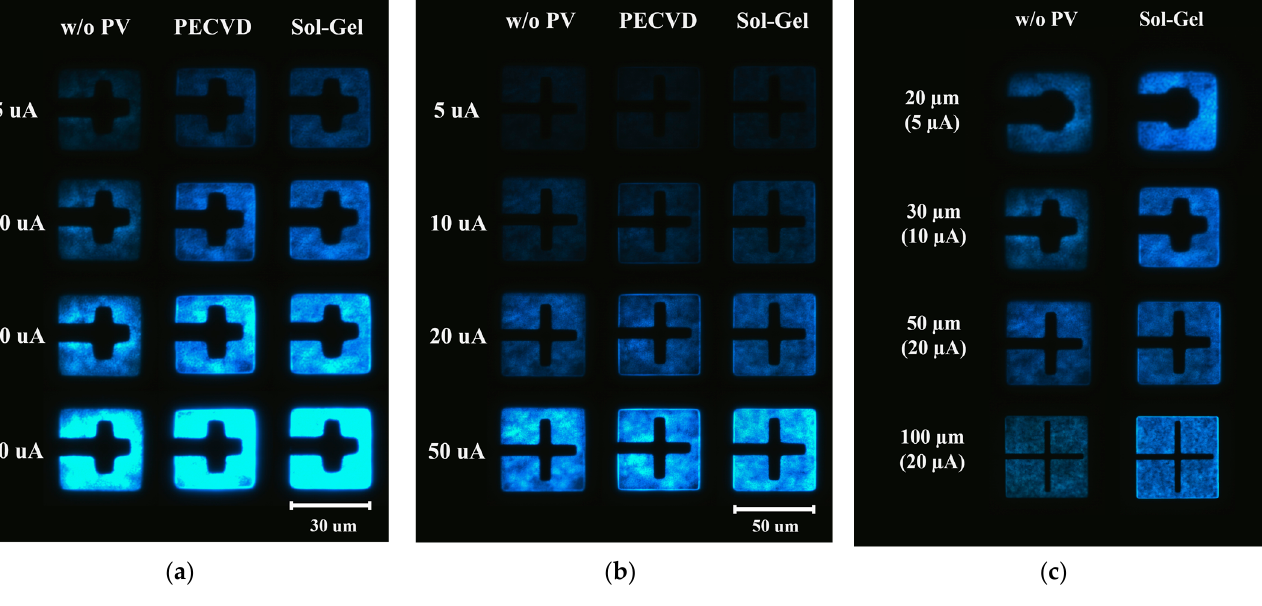
( b ) Figure A3. EL emission images of S1, and S3 presented as a 3D stereogram in ( a ) and a 2D intensity profile in ( b ).